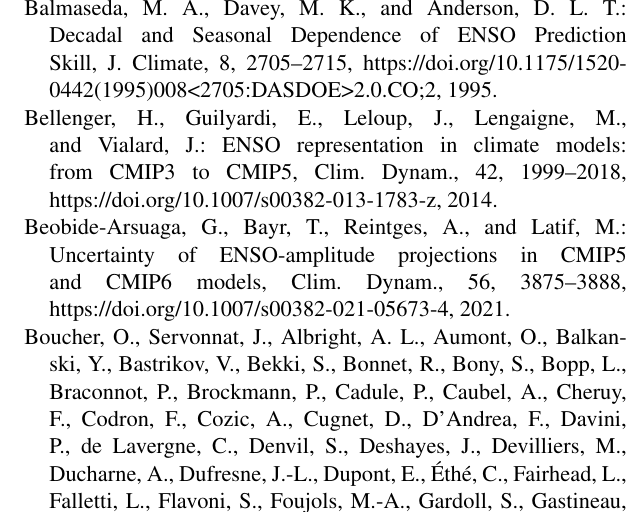
Fig. 8. XW made Figs. 3, 6, S1, S2, S5, S6, S7, and